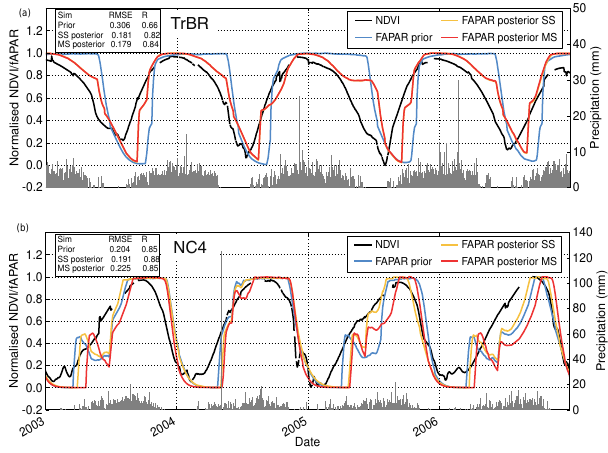
Figure 5. Example time series (2002–2008 period) for the trop- ical deciduous PFTs for which phenology is driven by moisture availability. The two panels compare the normalised simulated fAPAR to the normalised MODIS NDVI (black curve) prior to (blue curve) and after the optimisations (orange curve = SS opti- misations; red curve = MS optimisation) for a (a) TrBR tree site (5.77 ◦ S, 25.92 ◦ E) and a (b) NC4 grass site (10.08 ◦ N, 4.32 ◦ W). The prior and posterior RMSE and R are given in the upper left boxes. The grey vertical lines show the daily